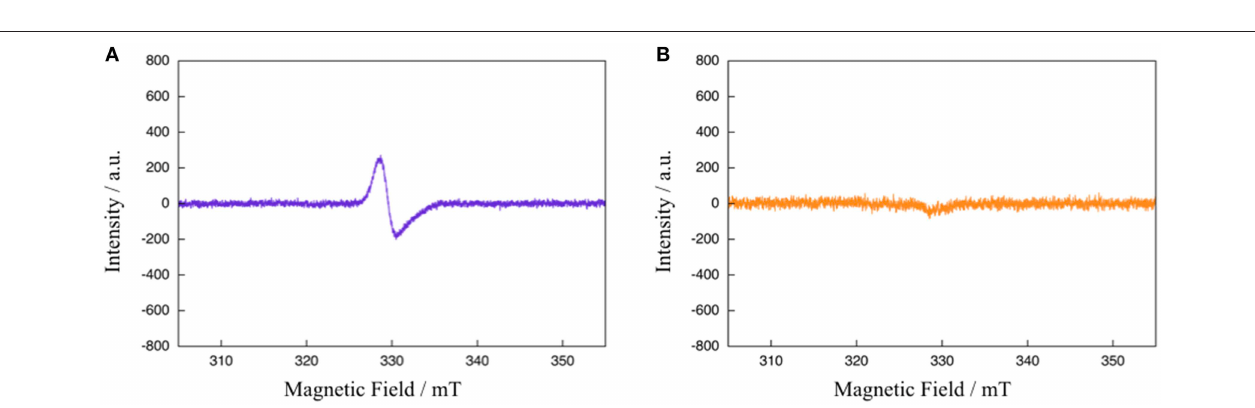
Frontiers in Chemistry |